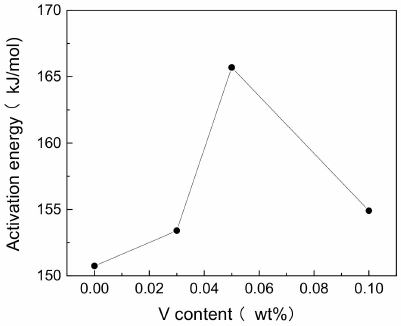
Figure 9. Relationship curve between thermal deformation activation energy Q and V